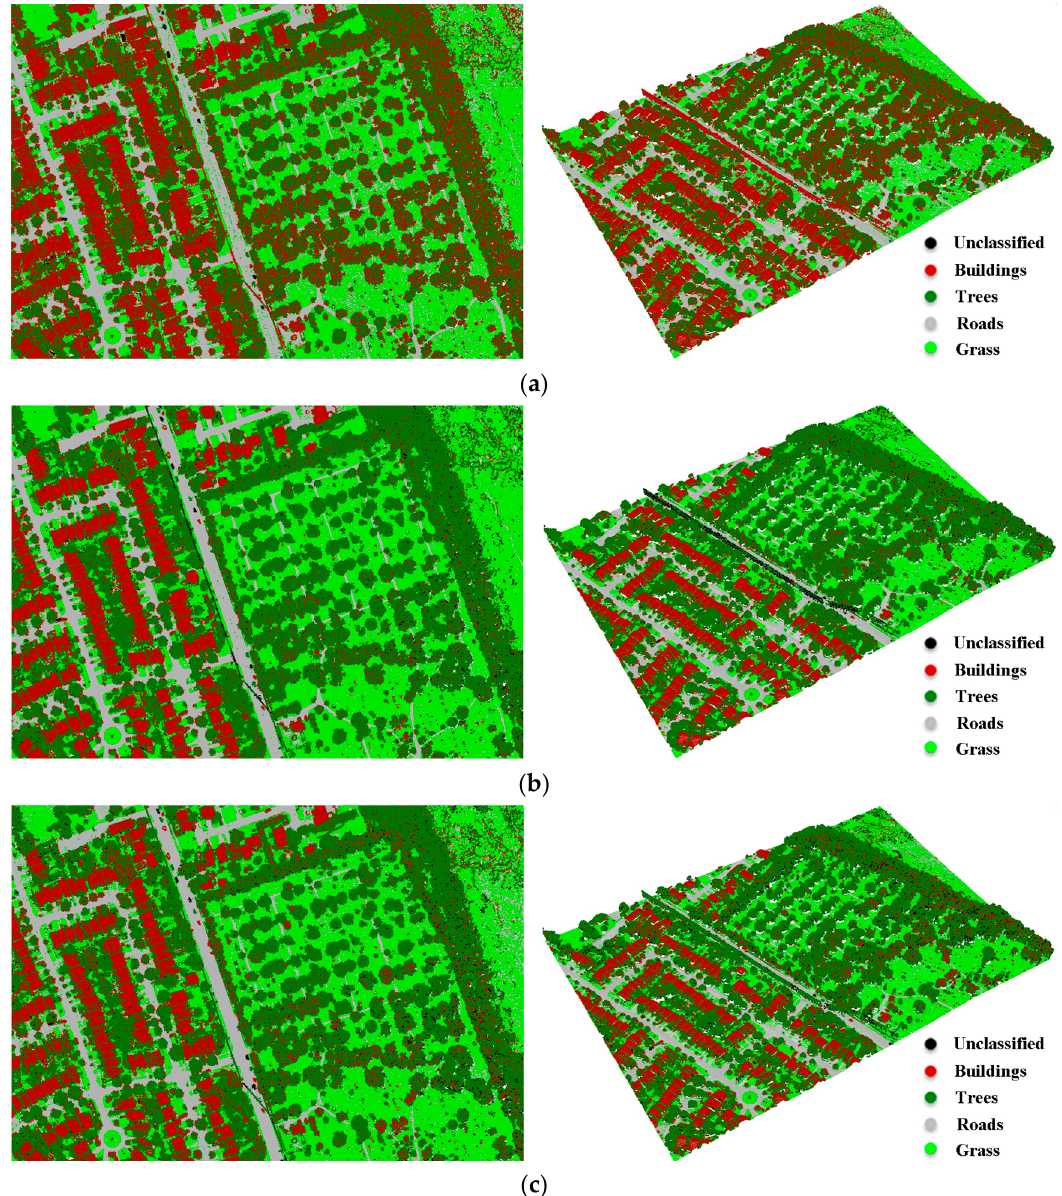
Figure 8. Classified LiDAR points based on: ( a ) NDVI NIR-MIR ; ( b ) NDVI NIR-G ; ( c ) NDVI MIR-G ; (left: (2D view); right: (3D view)). Table 6. Confusion matrix for point classification based on NDVI NIR-MIR .